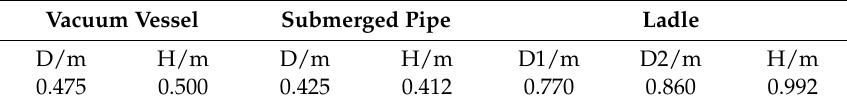
Table 1. Geometrical parameter of single snorkel